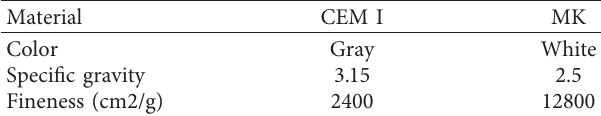
Table 2: Physical characteristics of OPC and